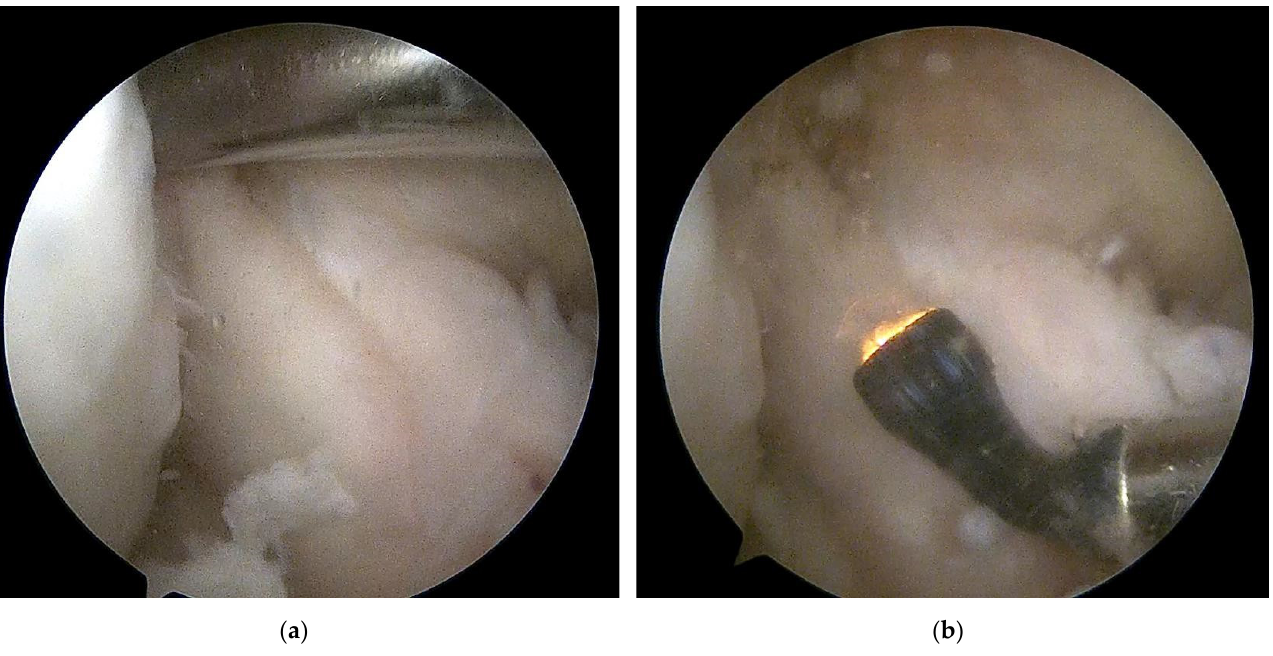
Figure 1. Intraoperative image of knee arthroscopy: ( a ) The method of microfracture in the area of the ACL femoral attachment ( b ) Electrocoagulation of ACL femoral attachment. Own source Pogorzała A.